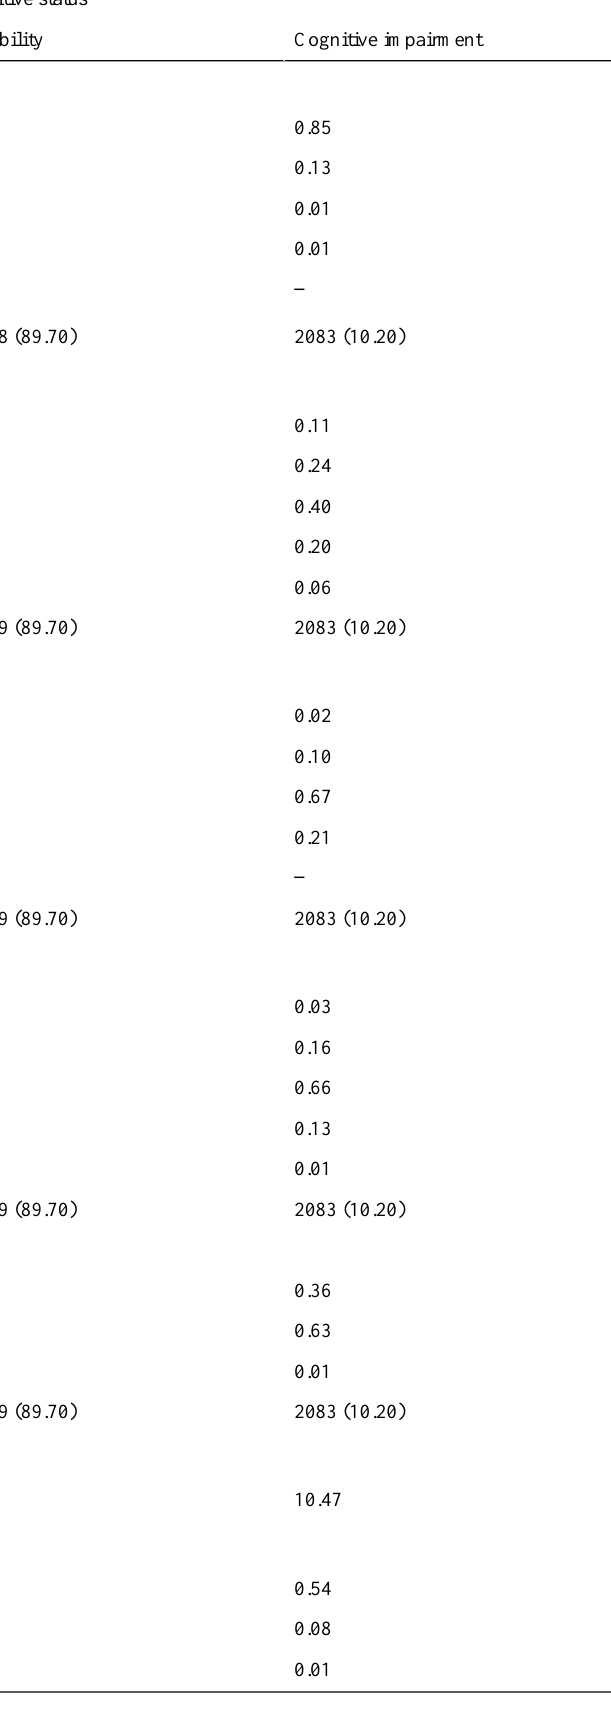
Cognitive status